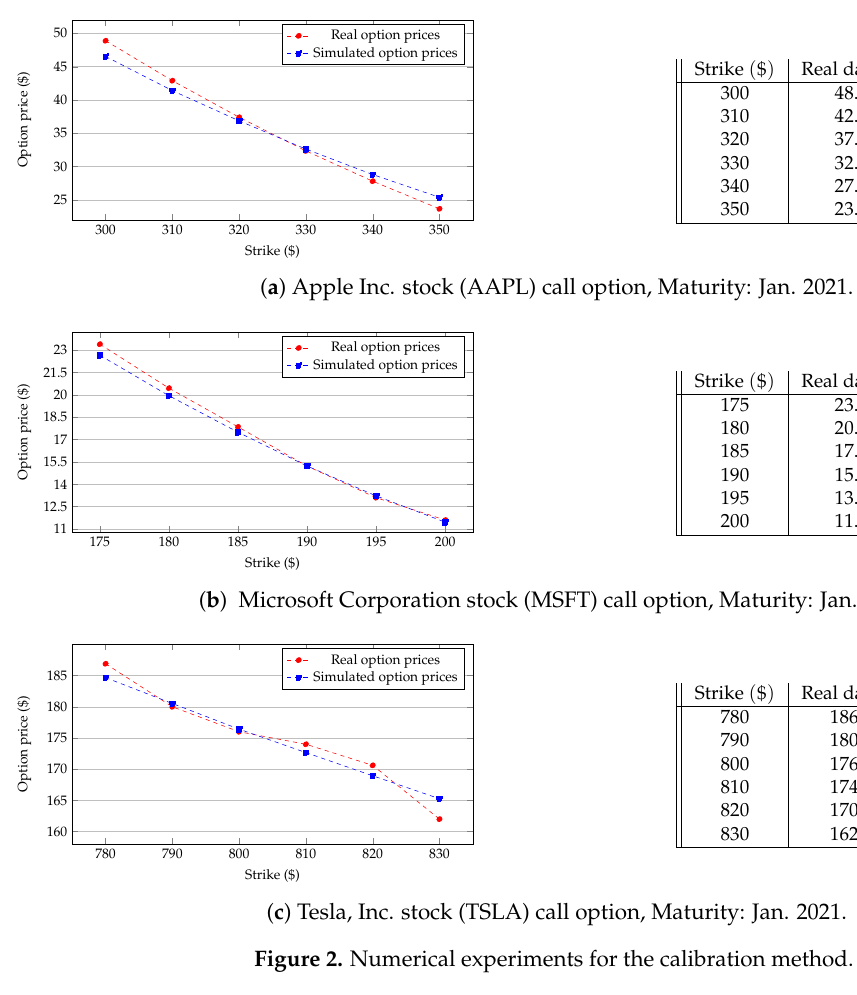
Figure 2. Numerical experiments for the calibration